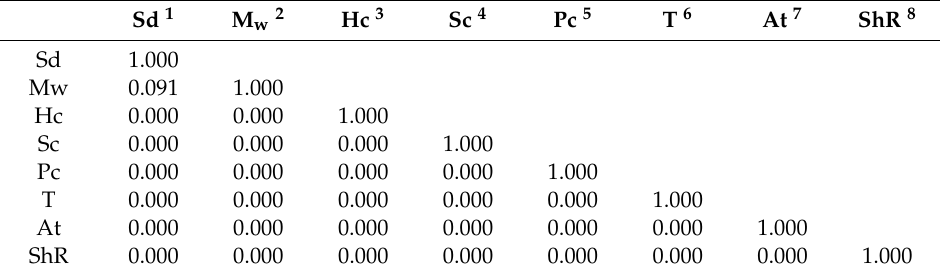
Table 3. Confounding evaluation using Pearson Correlation